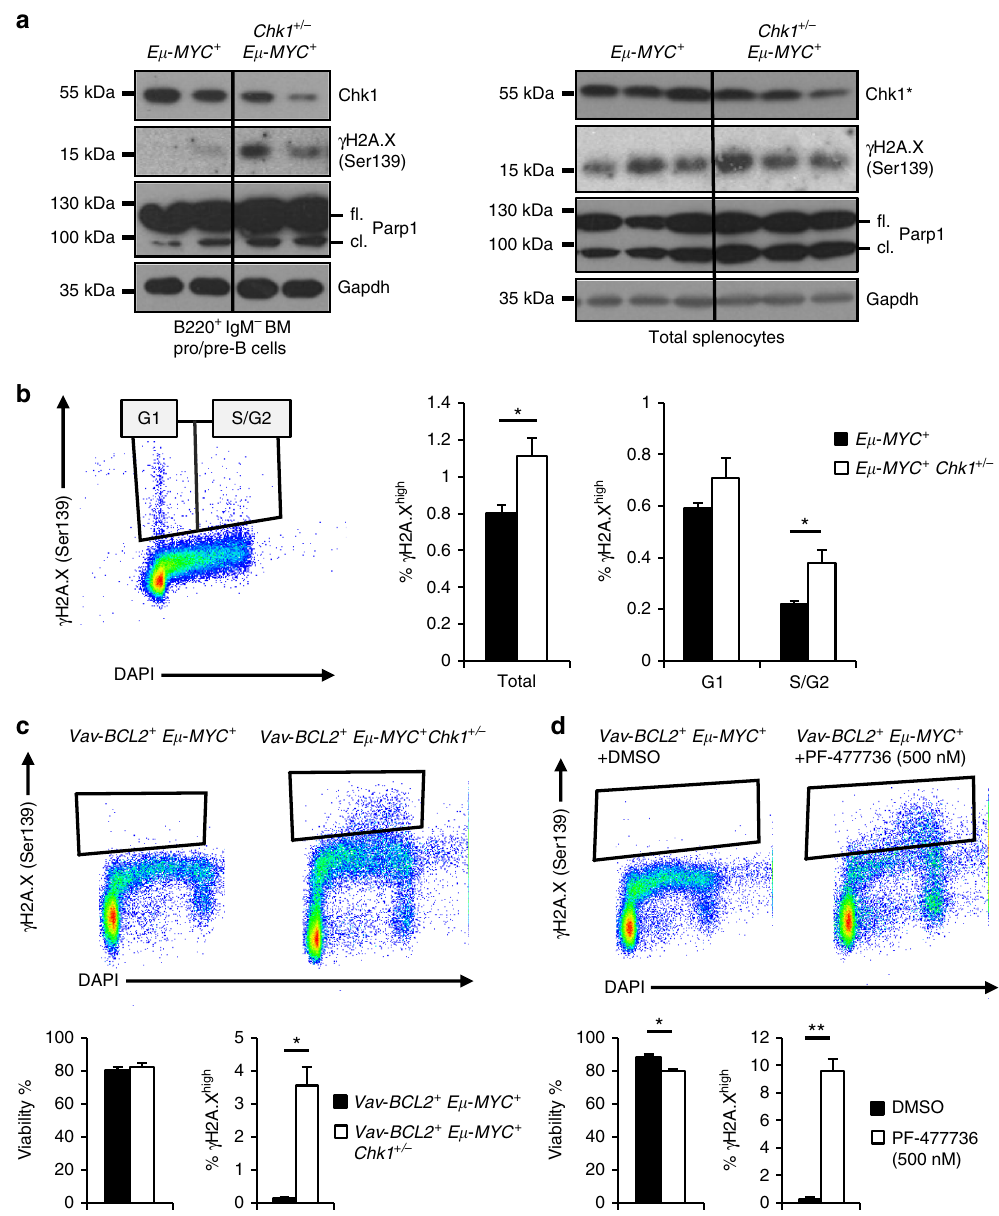
Fig. 6 Haploinsuf fi ciency in Chk1 predisposes to DNA damage in response to MYC overexpression. a B220 + IgM − pro/pre B cells FACS sorted from the bone marrow (left) or total splenocytes of mice of the indicated genotypes were processed immediately for immunoblotting using the indicated antibodies. * Indicates that the same CHK1 western is also shown in Fig. 5a, bottom right, lanes 7 – 12. Membranes were reprobed for PARP1 and γ H2A.X here b FACS sorted bone marrow B220 + IgM − pro/pre B cells were fi xed in ethanol and then processed for intracellular γ H2A.X staining. Bars represent means of n = 4 – 5 ( E µ -MYC + / E µ -MYC + Chk1 + / − ) animals ± S.E.M. c , d γ H2A.X staining of pre B cell lines generated from the bone marrow of 2-weeks-old VavBCL2 + E μ -MYC + Chk1 + / + or VavBCL2 + E μ -MYC + Chk1 + / − mice. c Steady state γ H2A.X -levels d γ H2A.X -levels of VavBCL2 + E μ -MYC + cells treated with 500 nM PF- 477736 (CHK1i) or solvent control (DMSO) for 24 h ( n = 3). Bars in c and d represent means of n = 3/genotype or treatment ± S.E.M. * p < 0.05, ** p < 0.01, *** p < 0.001 using unpaired Student ´ s t test. Abbreviations: fl . full length, cl. cleaved fragment of lymphocytes facing DNA damage that may reduce the chances of clonogenic outgrowth.